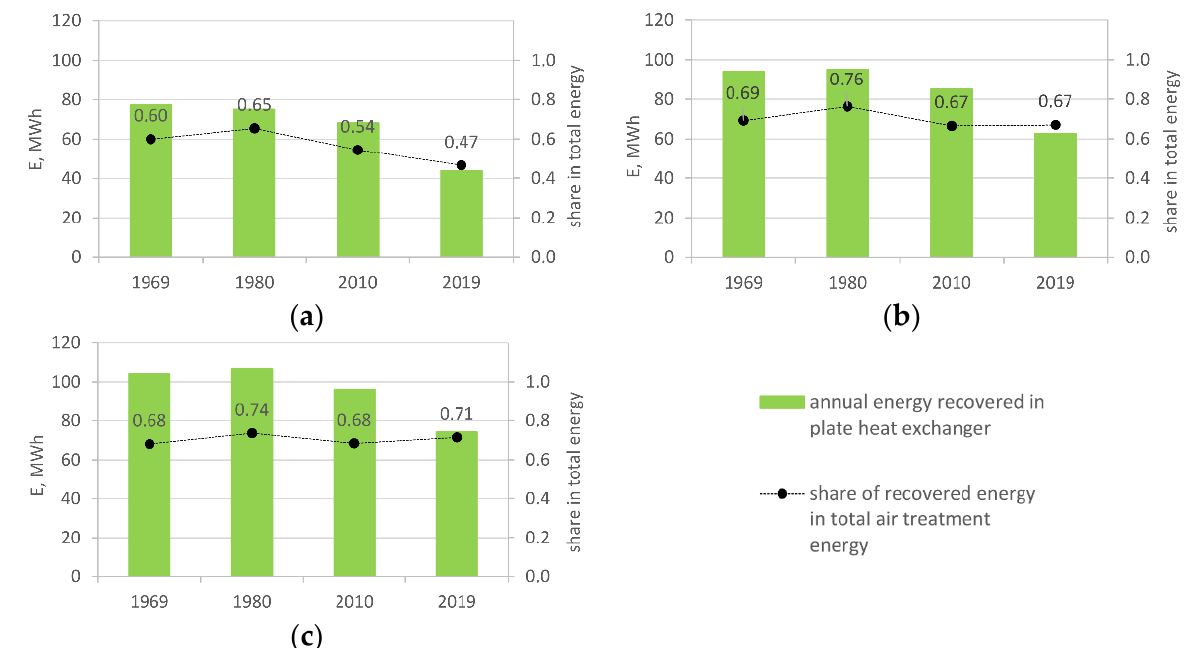
Figure 16. Energy recovered in plate heat exchanger and share in total air treatment energy: ( a ) t sup 2 = 12 ◦ C, ( b ) t sup 1 = 15 ◦ C, ( c ) t sup 3 = 18 ◦